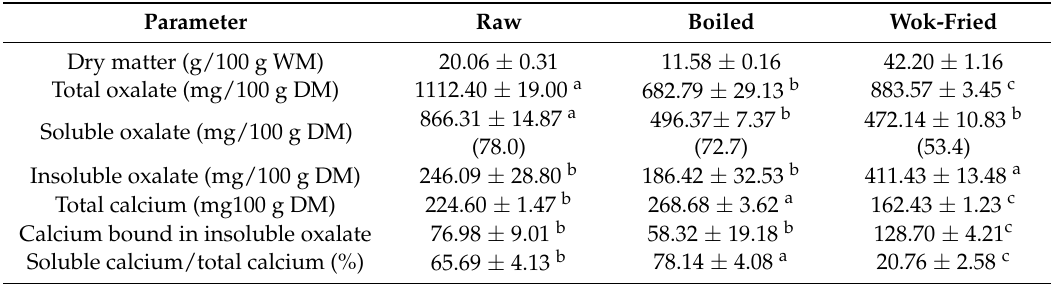
Table 3. Mean dry matter, total, soluble, and insoluble oxalates, total calcium and calcium bound